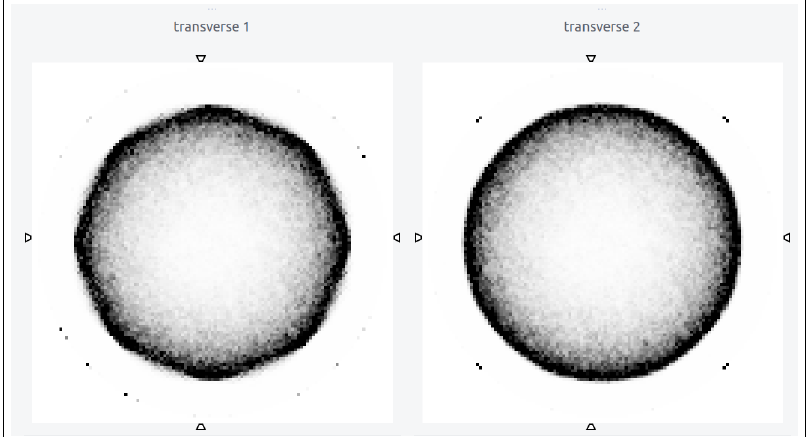
Figure 6. Transverse planes of the reconstructed images of a uniform cylinder simulated in GATE using the “BlocksOnCylindrical” class, with only true coincidence and no data correction with: old forward projector ( left ) and new amended forward projector ( right ).